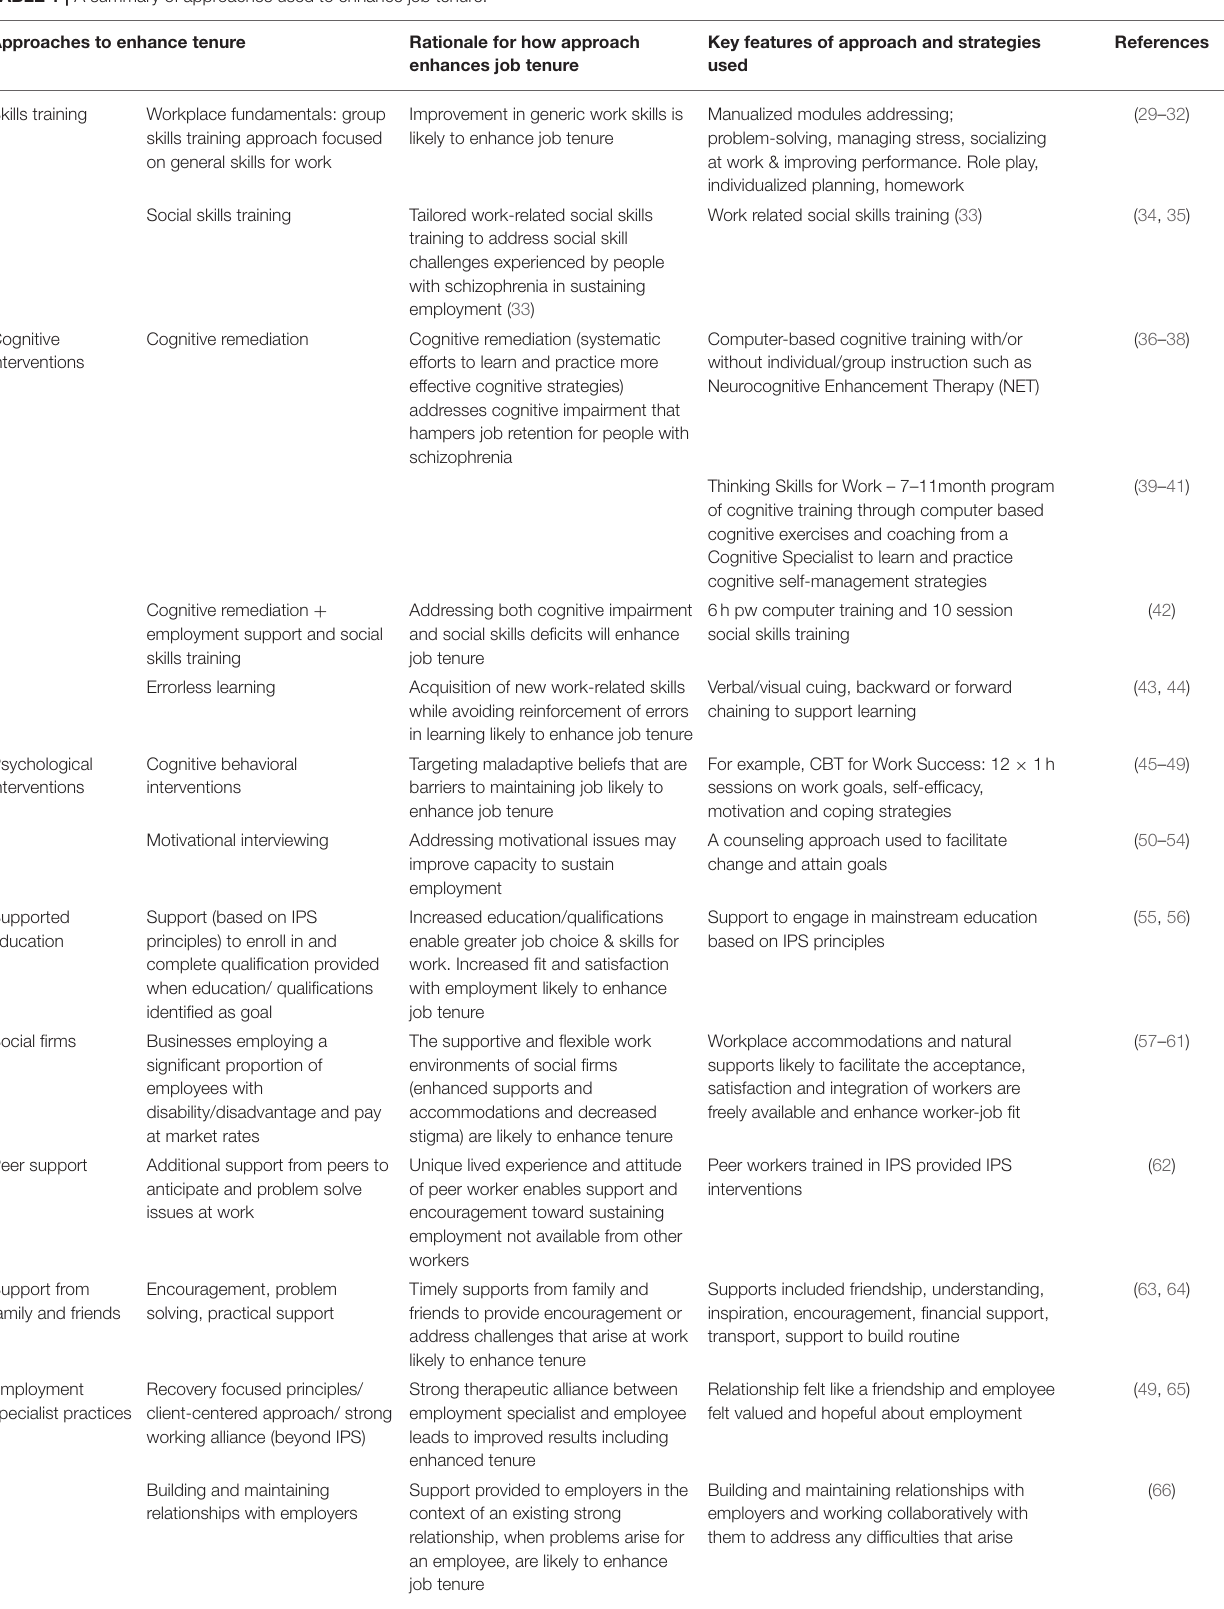
TABLE 1 | A summary of approaches used to enhance job